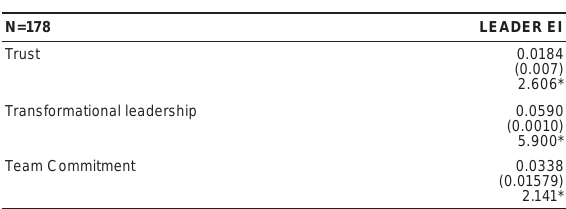
Table 3 Gamma matrix of the structural model